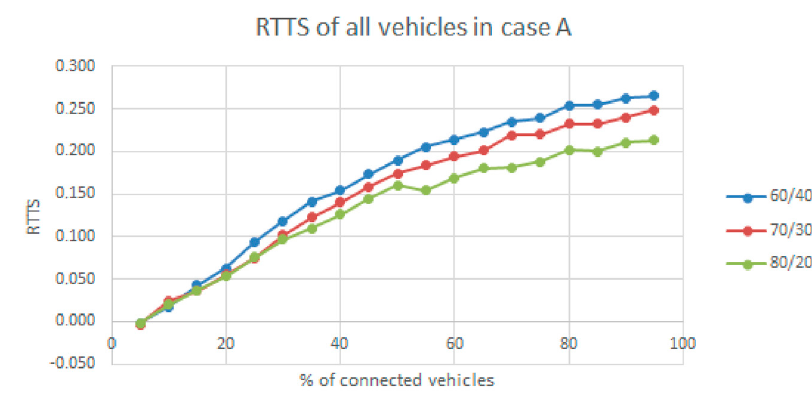
Figure 12. RTTS for all vehicles in Case A.